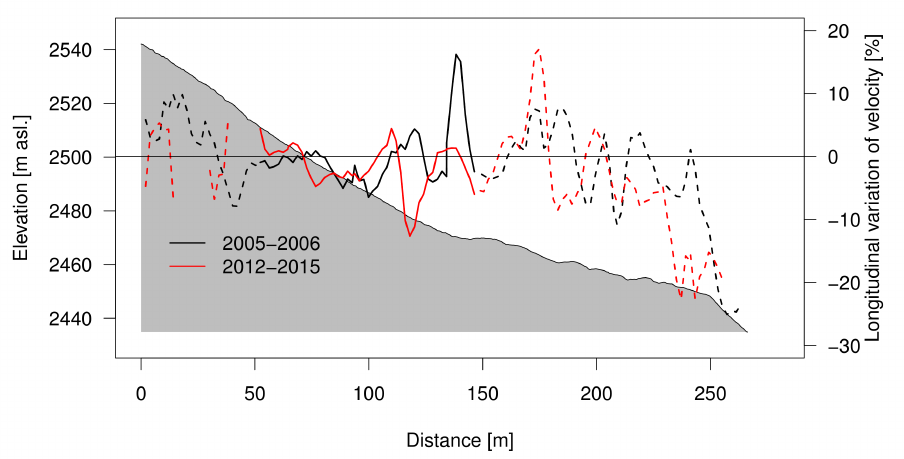
Figure 7. Relative spatial variation of velocity along the longitudinal axis of the Laurichard rock glacier for the slowest period (2005–2006, in black) and the fastest period (2012–2015, in red). Positive values indicate an increasing velocity towards downslope (extensive deformation), whereas negative values indicate a slowing down (compressive deformation). The plain line is used in the central section of the profile, which is referred to later on (see Figure